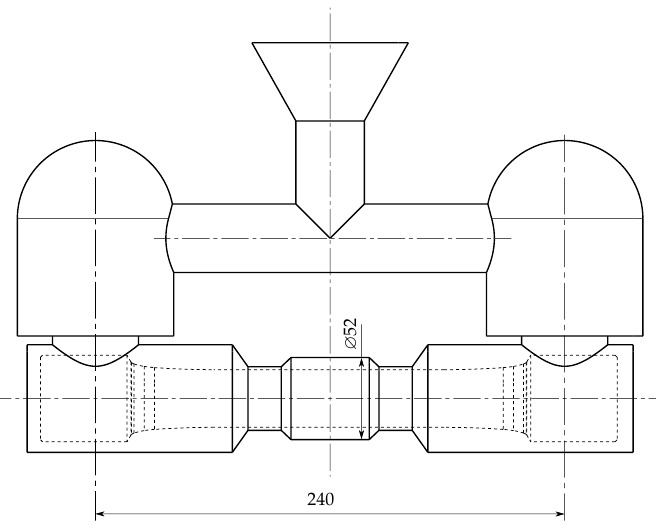
Figure 10. Model of the mould configuration including the final specimen geometry.